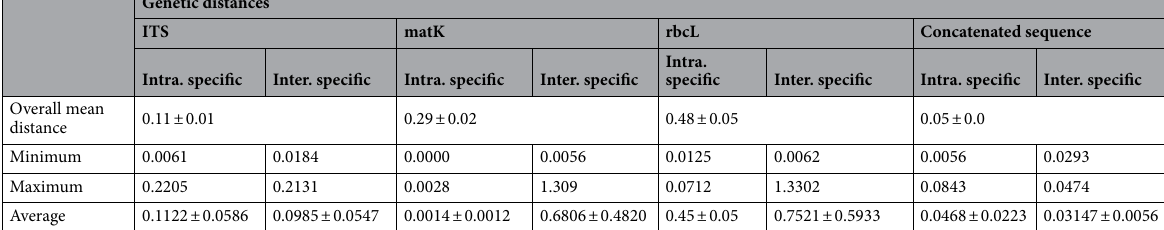
Table 2. Intraspecific and interspecific distances across all data.